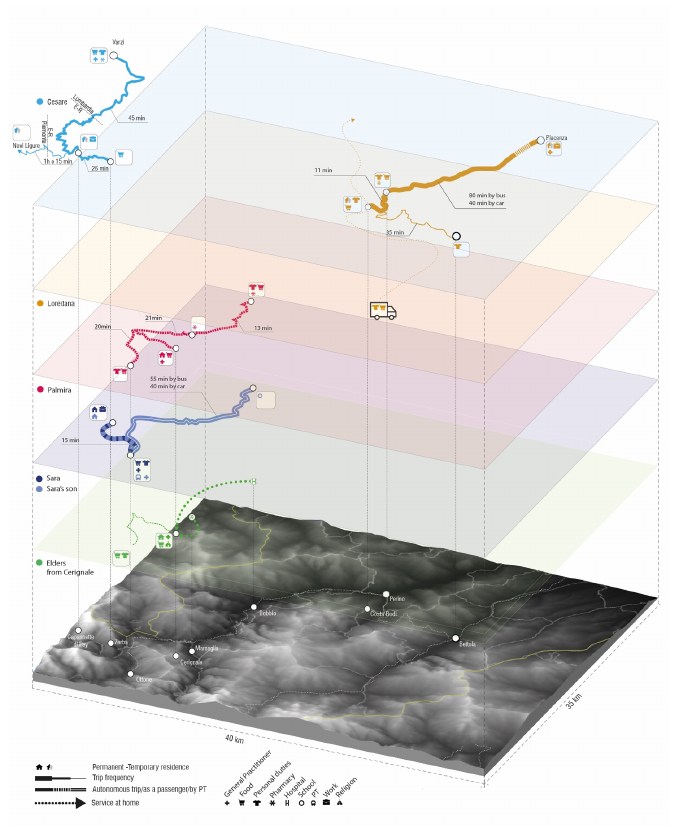
Figure 4: Map of activity